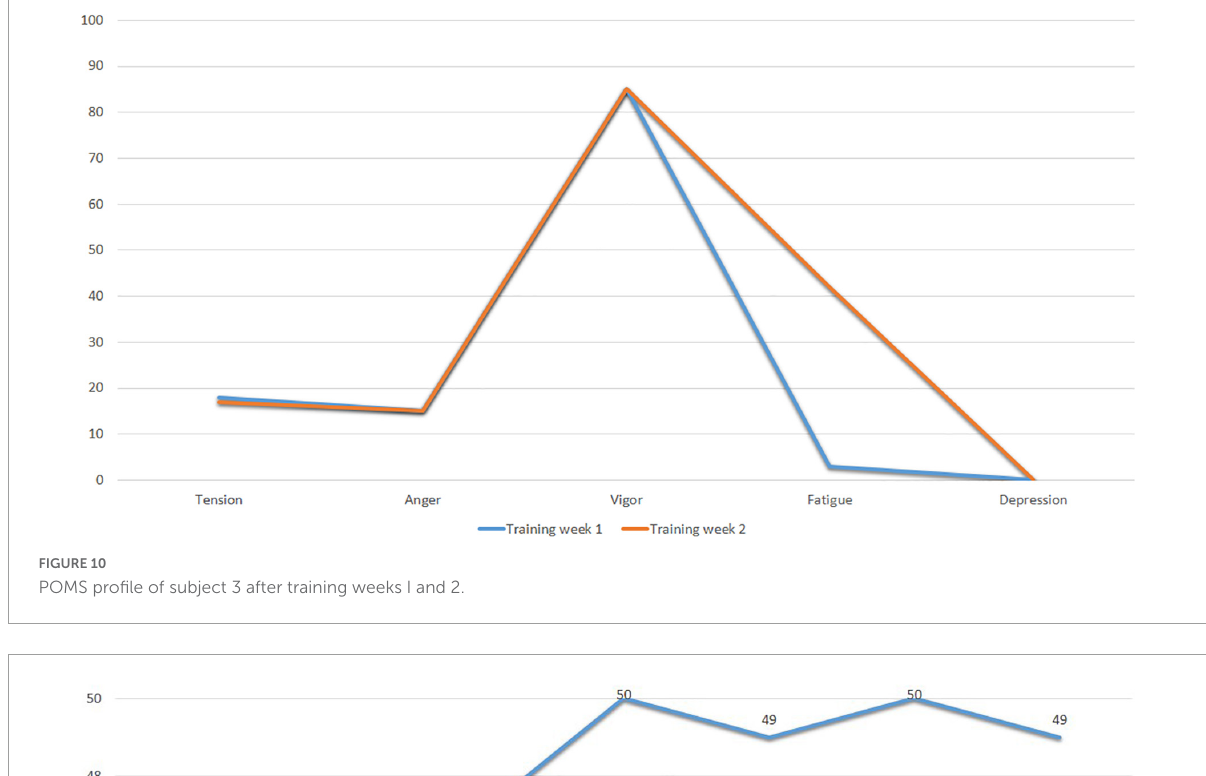
FIGURE10 POMS profile of subject 3 after training weeks I and 2.